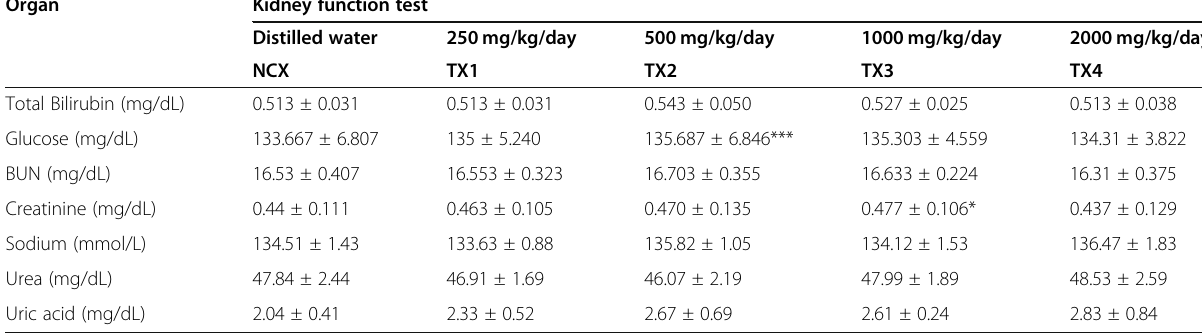
Table 8 Effect of polyherbal combination (PHC) on kidney function test Organ